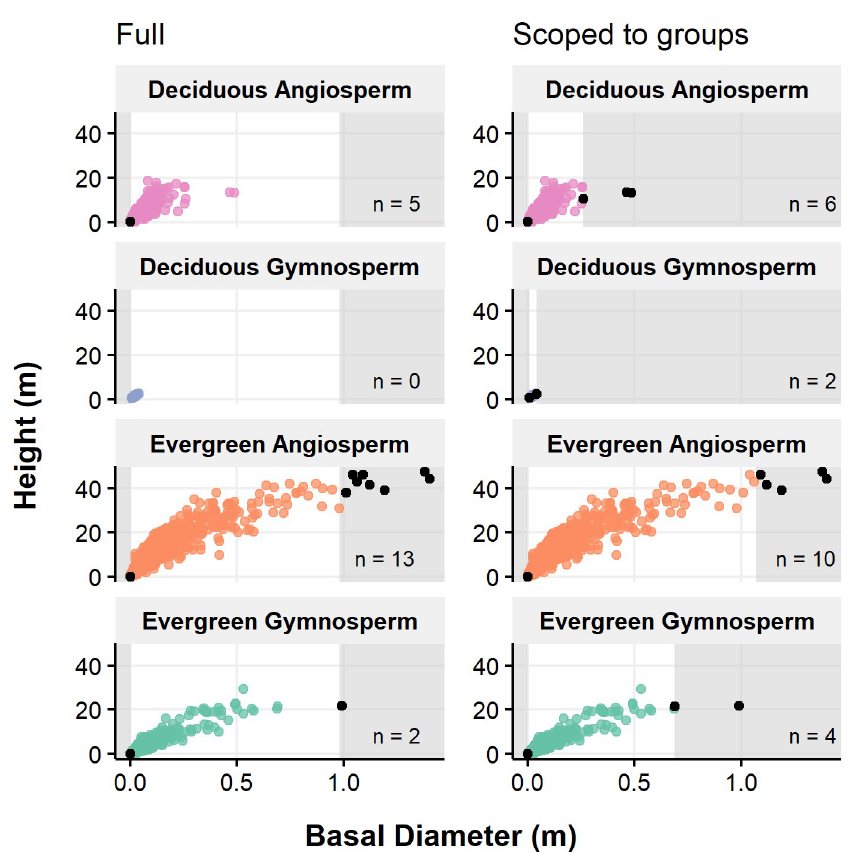
Fig 2. Example application of statistical filtering. A percentile threshold filter (0.01 and 0.99) is applied to the full range or scoped to groups (panels, see bold text) on the x-variable. Trait data from BAAD [31] is used to illustrate the impact on bivariate relationships across plant functional types, where the gray shading indicates the filtered variable space and text labels count the excluded observations (e.g.,” n = 2”). Note, the figure was not generated in